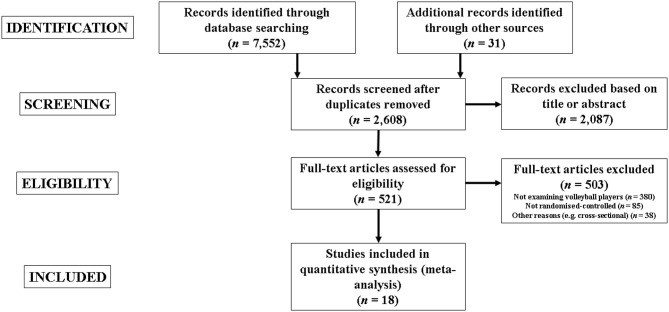
Flow diagram of the search process.